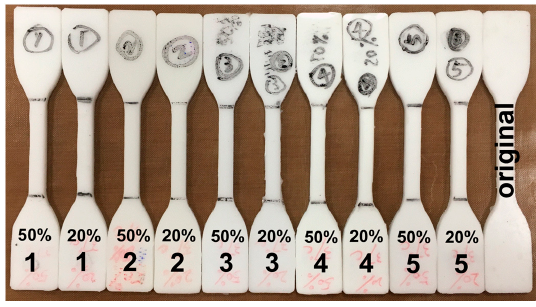
Figure 9. SPPM samples after heated at 50 °C for five minutes. In each sample, the applied programming strain is indicated at right above the hybrid type (1 to 5). The right sample is original as marked without any testing for comparison.